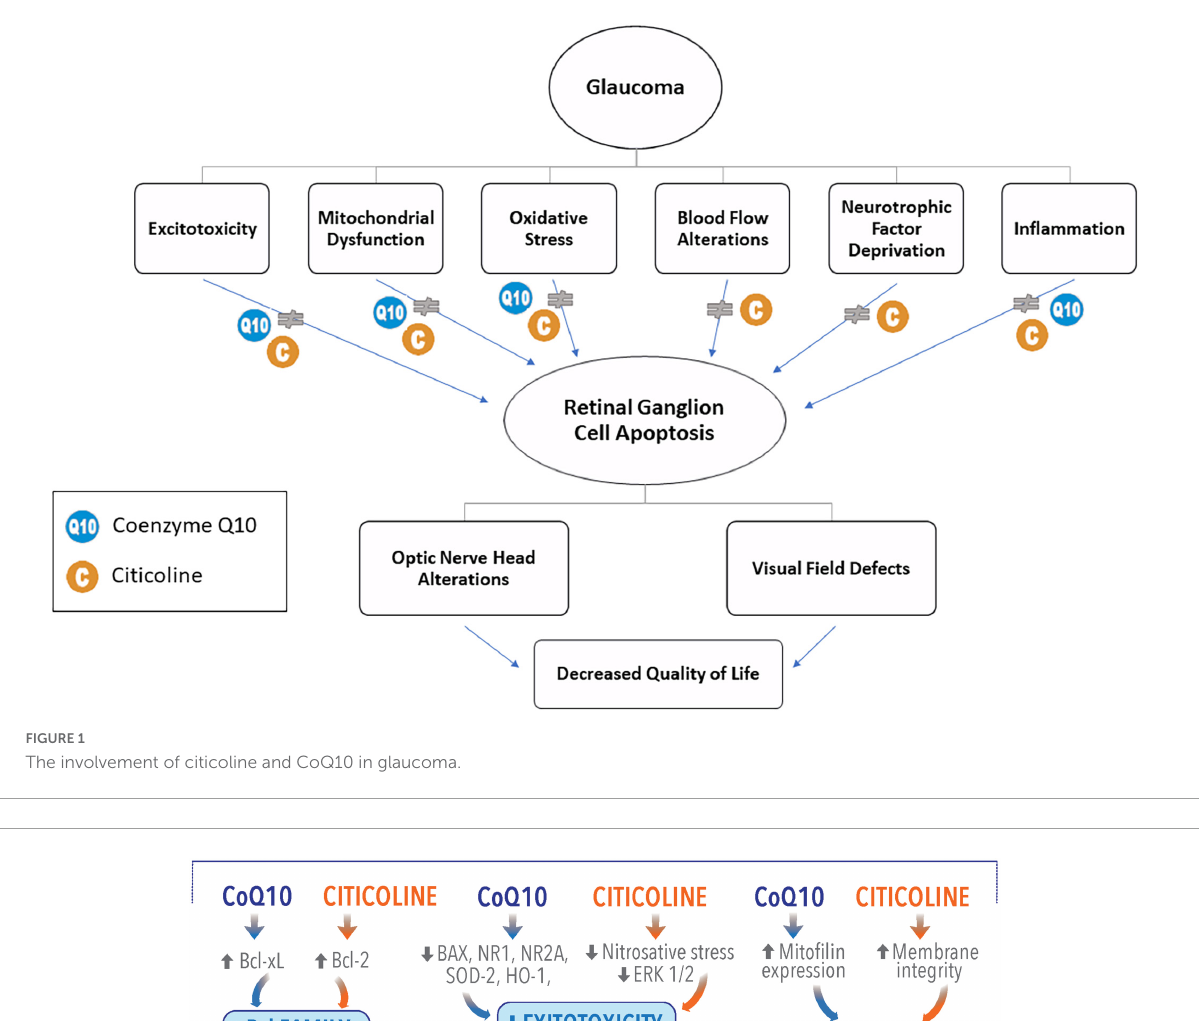
FIGURE1 The involvement of citicoline and CoQ10 in glaucoma.